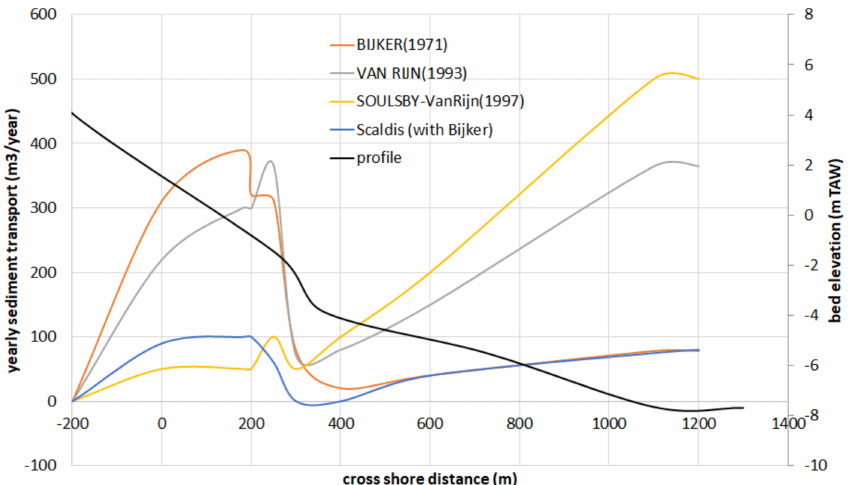
Figure 13. Comparison of the sediment transport rates using different formulations in Unibest with the results of Scaldis-Coast, for a relatively deep